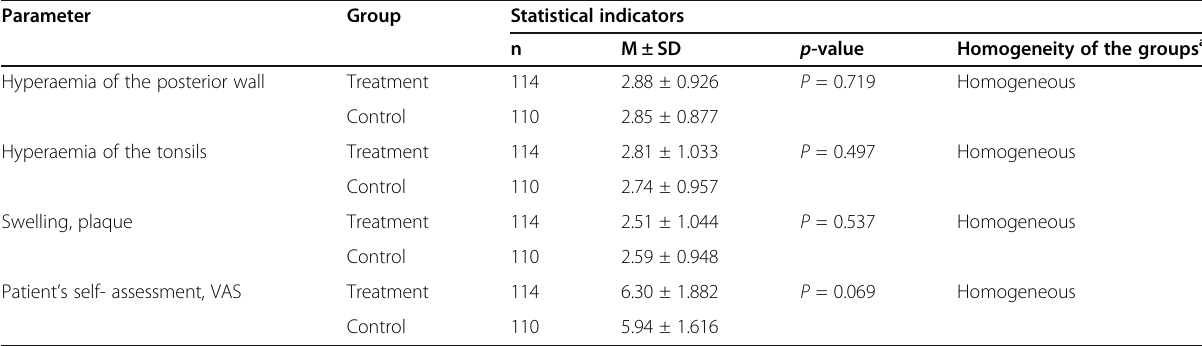
Table 4 The group analysis according to the local symptom severity and self- assessment value before treatment